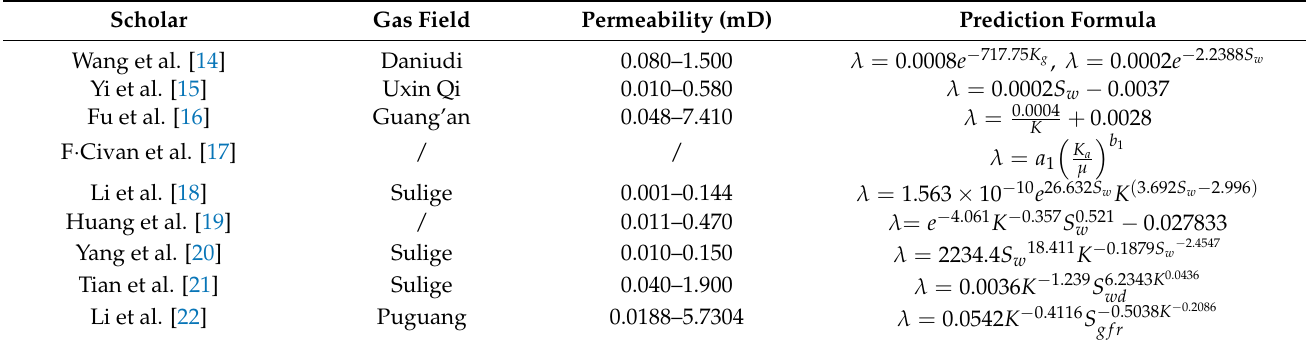
Table 1. The TPG prediction